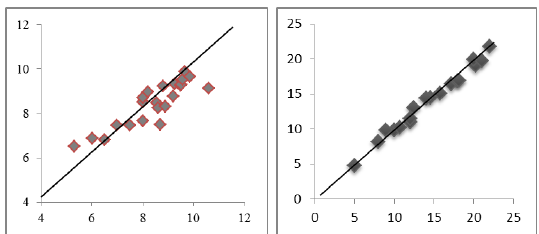
Figure 5. Validation of the estimated crown diameter (left) and crown base height (right) against field measured trees